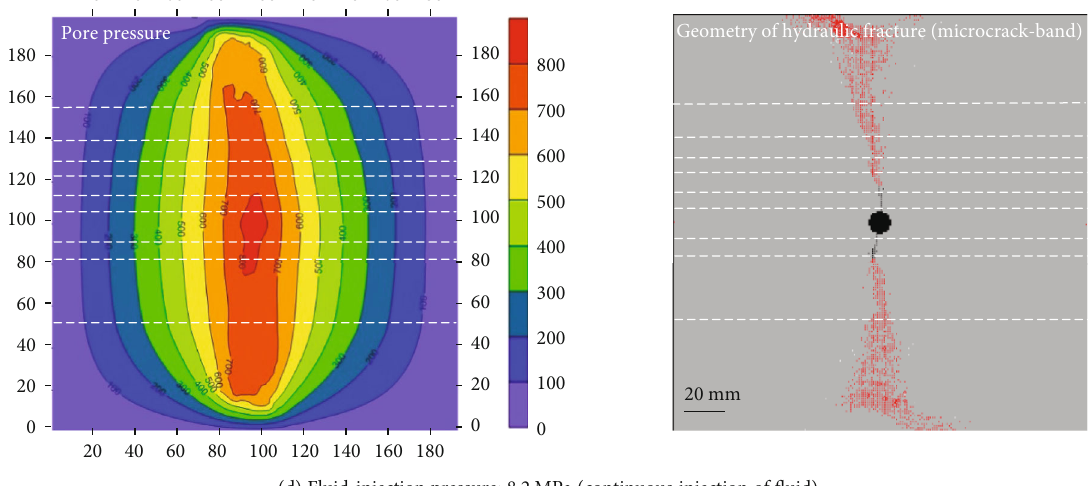
Figure 3: Pore pressures and hydraulic fracture (microcrack-band) geometries at di ff erent injection